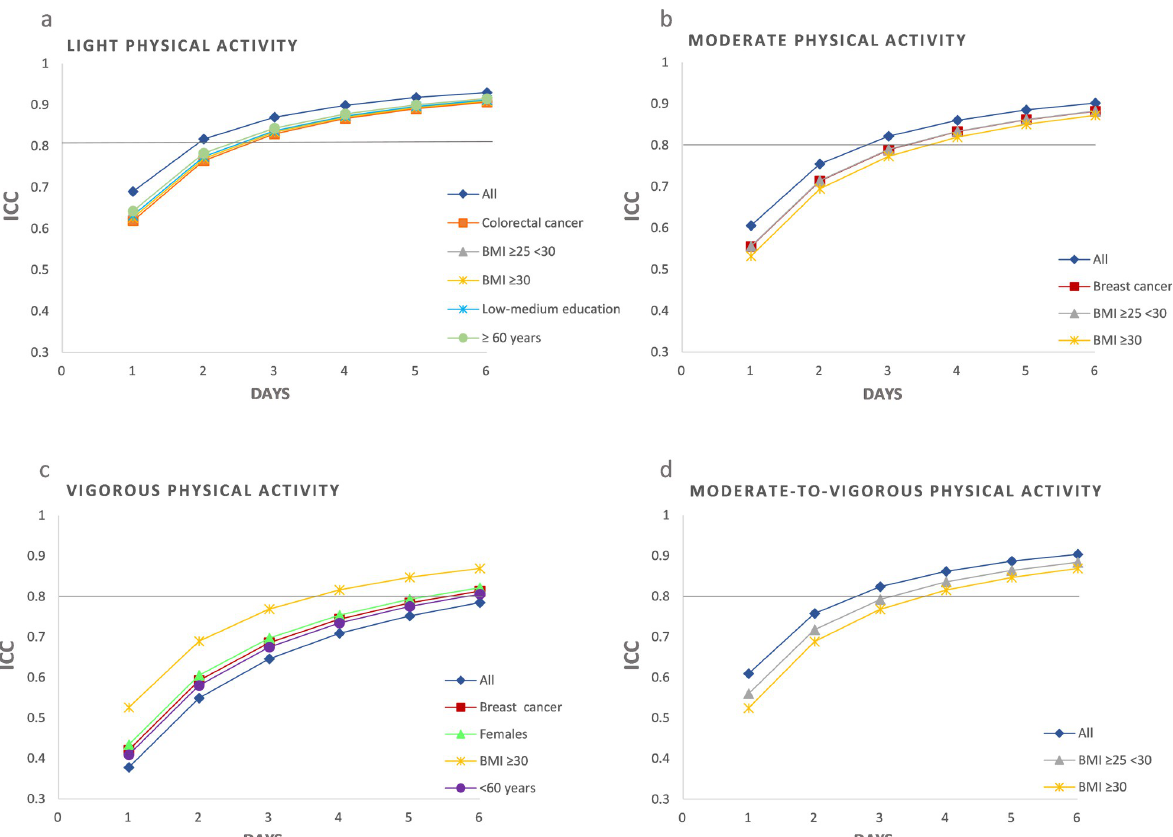
Fig 2. ICCs for each monitoring day in the total sample and in the stratified samples that deviated from the reliable number of days found for the whole sample of 736 cancer survivors. (a) Colorectal cancer survivors, participants with BMI � 25, low-medium education, or � 60 years old required an additional monitoring day for reliable estimates of LPA. (b) Four monitoring days were required for reliable estimates of MPA in participants with breast cancer or BMI � 25. (c) While reliable estimates of VPA were not obtained for the total sample, participants with BMI � 30 achieved reliable estimates with four monitoring days, and females, breast cancer survivors and participants < 60 years old achieved reliable estimates with six monitoring days. (d) Participants with BMI � 25 required four monitoring days for MVPA.